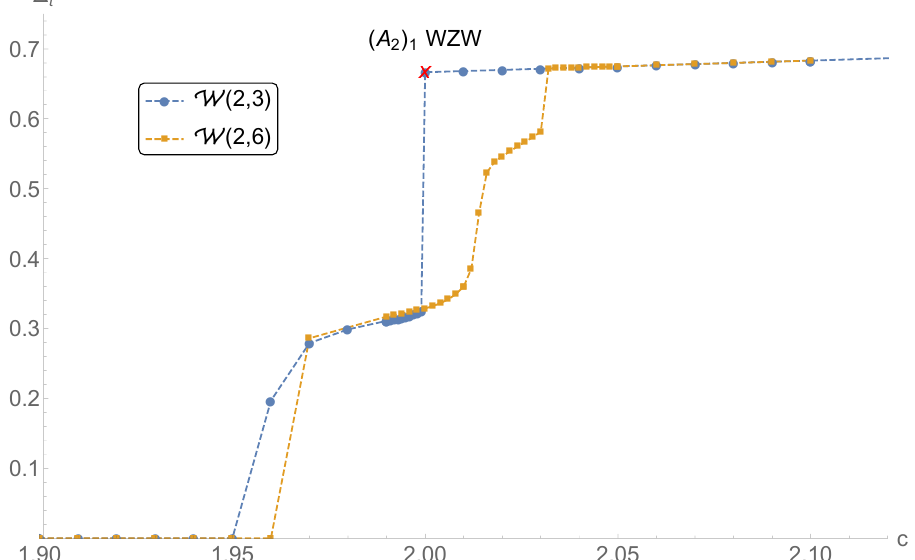
Figure 19. Numerical bounds on the twist gap for W (2 ; 3) and W (2 ; 6)-algebra. The upper bound obtained from the W (2 ; 3)-algebra realizes the ( A 2 ) 1 WZW model at the numerical boundary, while W (2 ; 6) does not.